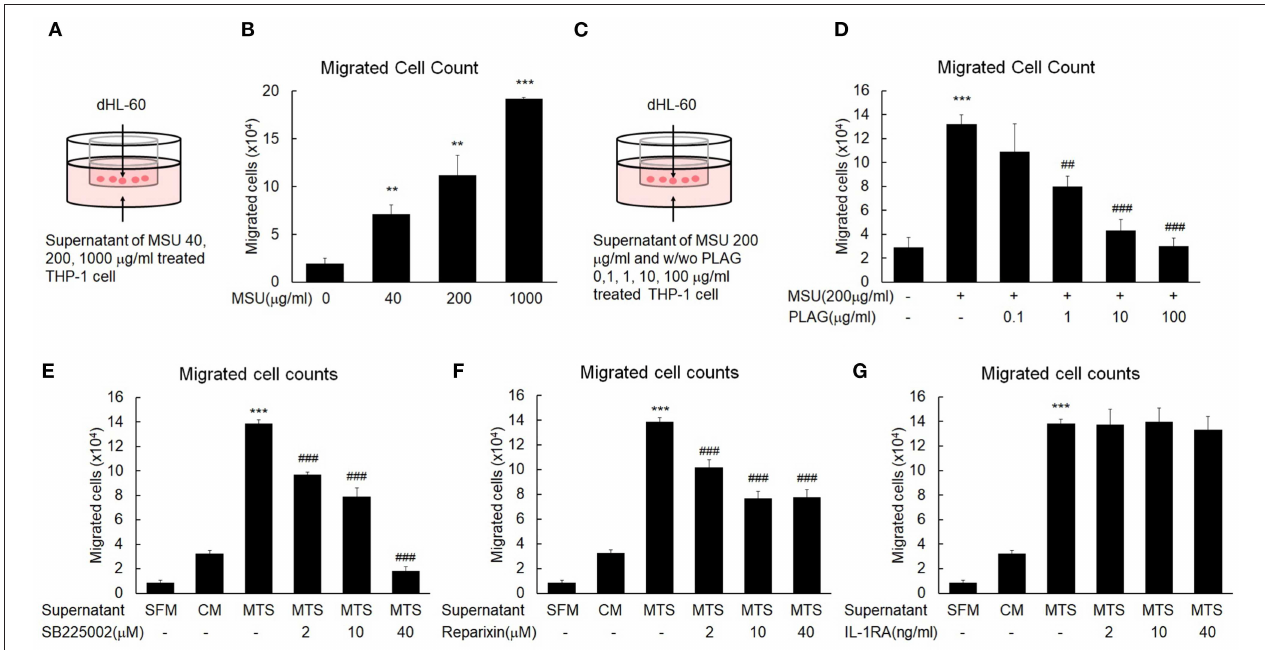
FIGURE 2 | MSU-stimulated THP-1 induces neutrophil migration and PLAG attenuates the mobile activity induced by MSU. (A) A transwell experimental scheme for neutrophil migration by the cell-free supernatant of MSU-stimulated THP-1. The number of dHL-60 cells migrated to the bottom chamber was quantified using a hemocytometer. (B) Chemotaxis of dHL-60 cells in response to cell-free culture supernatants obtained from the different doses (40, 200, or 1,000 µ g/ml) of MSU-treated THP-1 cells. (C) Transwell experimental scheme for the effect of PLAG on inhibition of neutrophil migration toward the cell-free culture supernatant of MSU-treated THP-1 cells. Different concentrations of PLAG (0.1, 1, 10, 100 µ g/ml) were treated in MSU-stimulated THP-1 cells, and the cell-free supernatants were placed on the bottom chamber. dHL-60 cells were added on the upper chamber, cultured for 24h in the culture supernatants. The transmigrated dHL-60 cells to the bottom chambers were counted using a hemocytometer. (D) Dose effect of PLAG on chemotaxis of dHL-60 cells in response to cell-free culture supernatants obtained from MSU-treated THP-1 cells. (E,F,G) dHL-60 cells were treated with SB225002 (2, 10, 40 µ M) or reparixin (2, 10, 40 µ M) or IL-1RA (2, 10, 40ng/ml) and then placed on the upper chamber to see chemotaxis toward the supernatant of THP-1 cells treated with MSU (200 µ g/ml). The number of transmigrated HL-60 cells was counted using a hemocytometer. Data are presented as mean ± SD. ** p < 0.01, *** p < 0.001, compared to the control group. ## p < 0.01, ### p < 0.001, compared to the MSU-treated group. dHL-60, differentiated HL-60 cells; SB225002, a selective CXCR2 antagonist; reparixin, inhibitor of CXC chemokine receptor type 1 and 2; IL-1RA, interleukin 1 receptor antagonist; SFM, serum-free medium; CM, control medium; MTS, MSU-treated THP-1